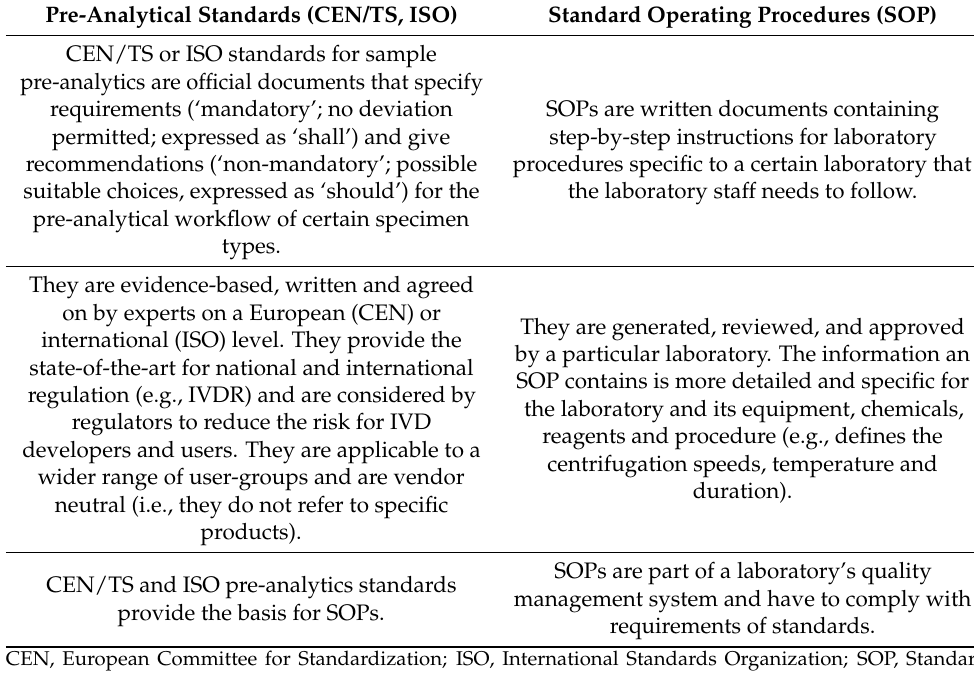
Table 1. Differences between Standards and Standard Operating Procedures